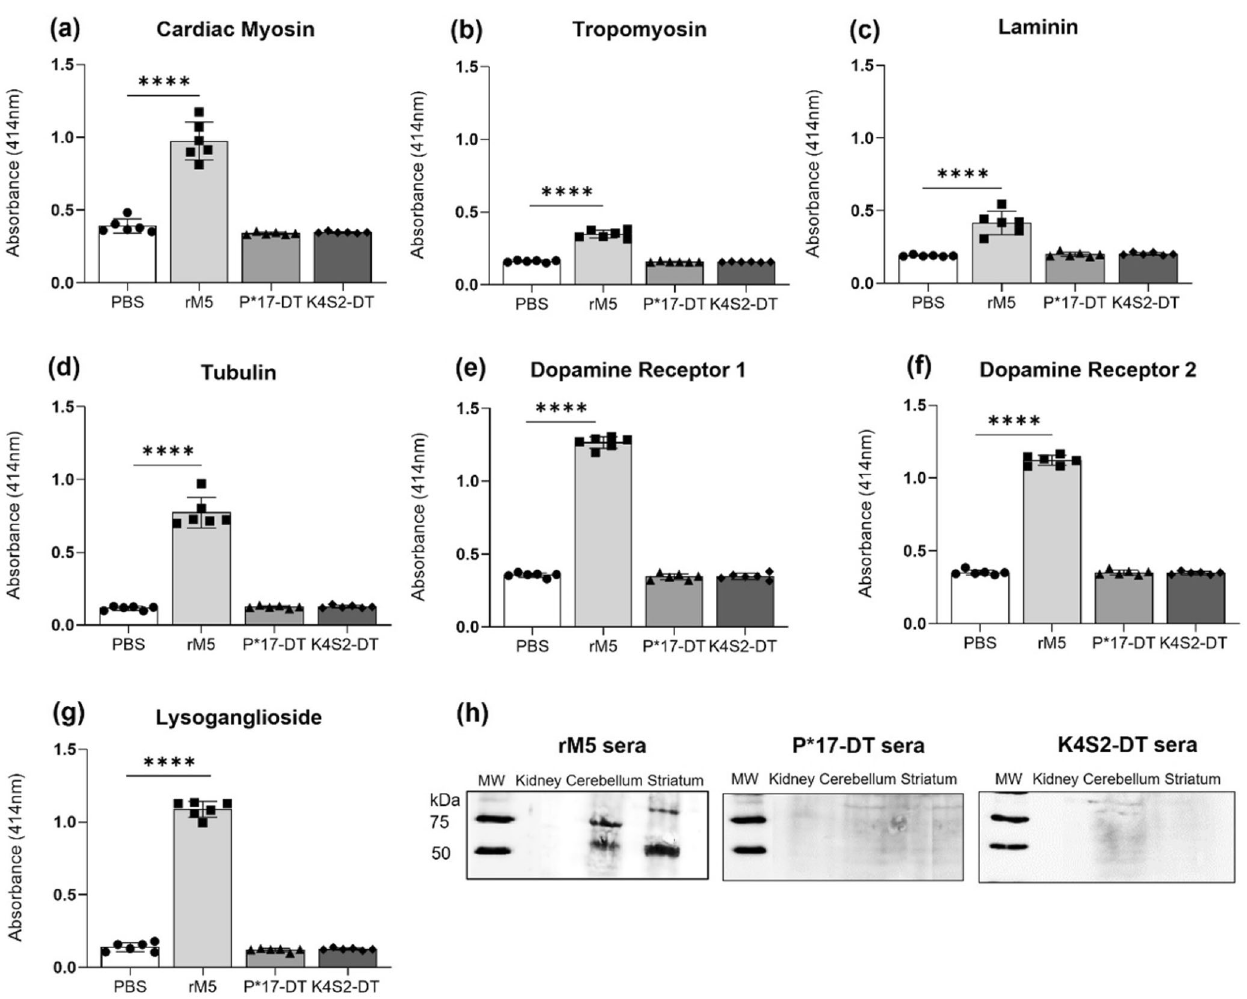
Fig. 4 Serum IgG cross-reactivity to host cardiac and neuronal tissue proteins. Serum IgG titre against cardiac myosin ( a ), tropomyosin ( b ), laminin ( c ), tubulin ( d ) dopamine receptor 1 ( e ) and 2 ( f ), and lysoganglioside ( g ) in rats ( n = 6) injected with PBS ( (cid:129) ), rM5 ( ▪ ), P*17-DT ( ▴ ) or K4S2-DT ( ♦ ) are shown. Absorbance values of day-35 rat sera at 1:400. Statistical analysis performed by one-way ANOVA with Dunnett multiple comparison. Signi fi cance to PBS group, * P < 0.05, ** P < 0.01, *** P < 0.001 and *** *P < 0.0001. Error bars represent standard deviation. Serum IgG cross-reactivity to endogenous proteins in lysates of cerebellum and striatum from naive rats ( h ). MW molecular